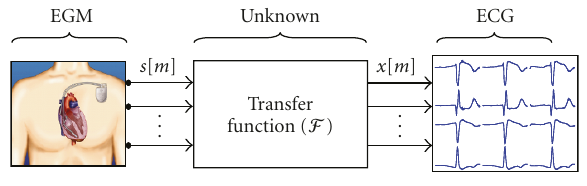
Figure 1: Problem